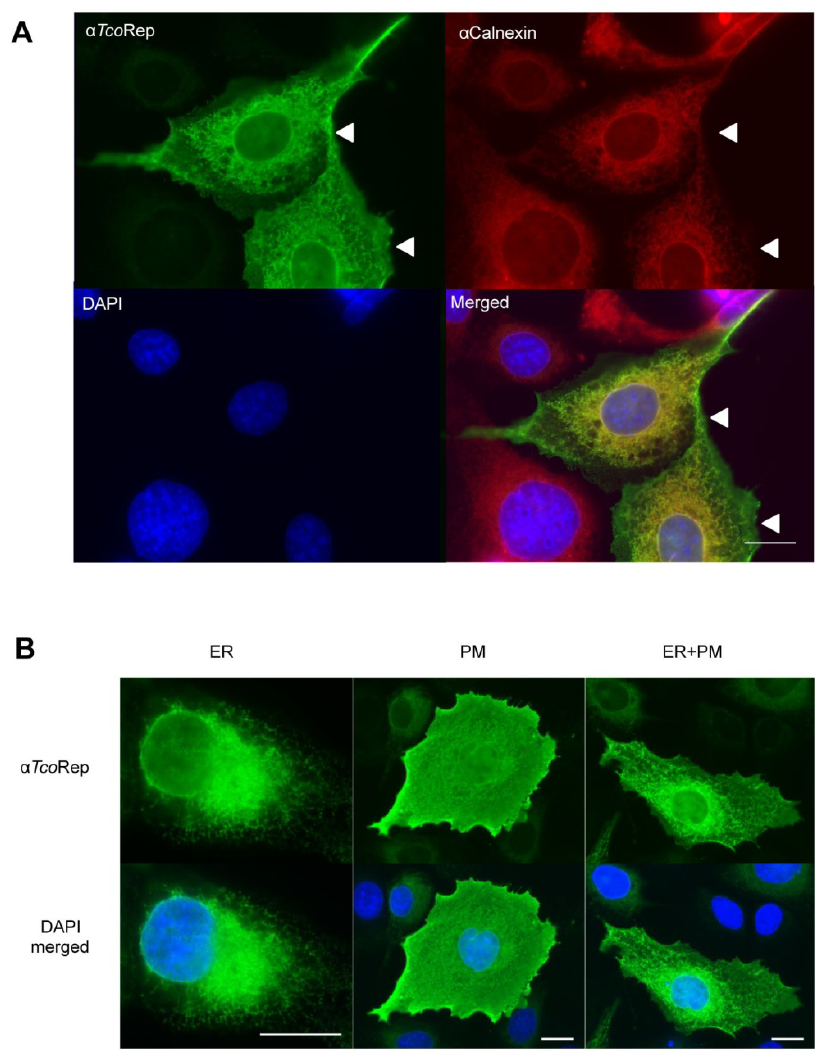
FIGURE 2: Immunofluorescence analysis of U-2 OS cells expressing a TcoClec protein. U-2 OS cells expressing a TcoClec protein are indicated (white arrowheads). (A) Cells were stained with anti-TcoRep, anti- calnexin and DAPI. Merged picture (bottom right) shows that TcoClec and calnexin colocalize partially. (B) Three patterns could be observed in the same propor- tions: endoplasmic reticulum (ER, left), plasma membrane (PM, middle) and both localizations (right). Cells were stained with anti-TcoRep and DAPI. Bar, 20